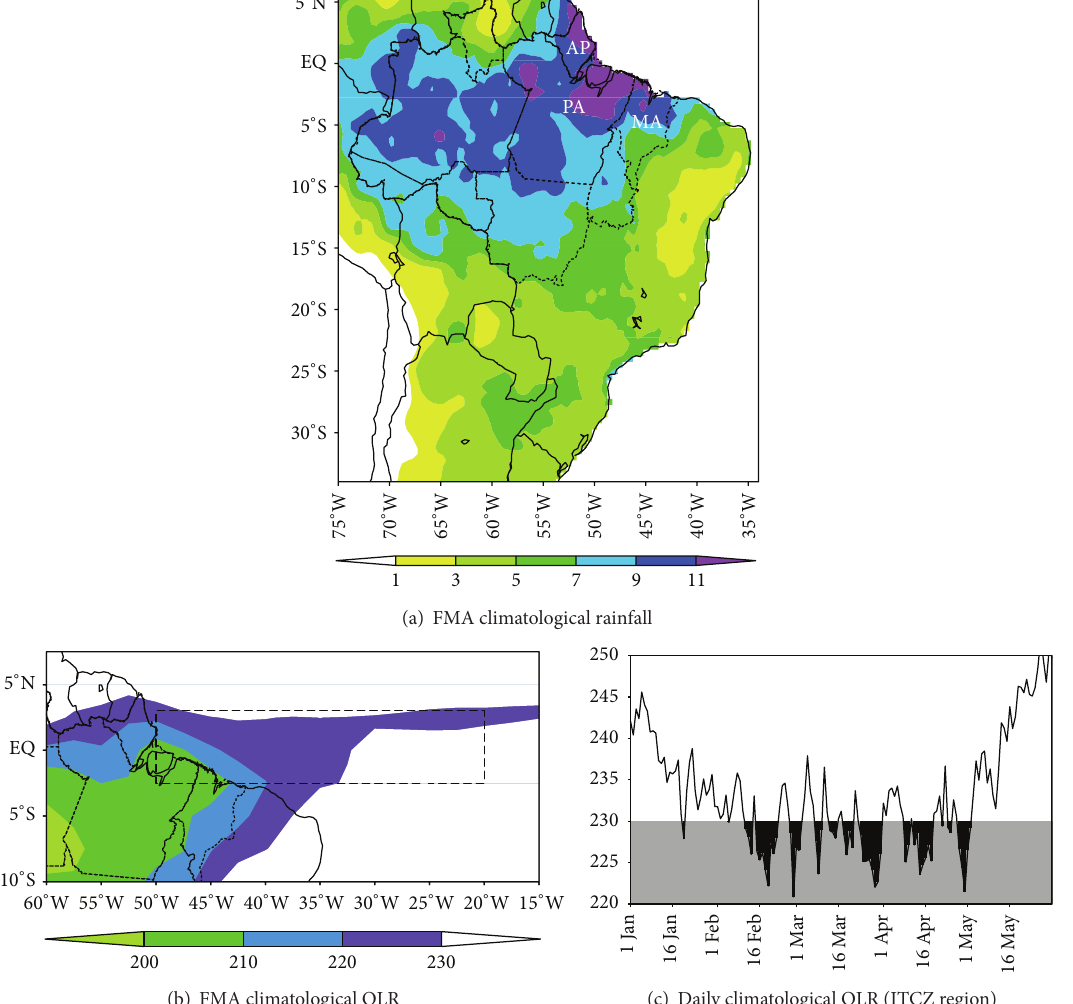
Figure 1: Climatology (1981/2010) for the FMA period of the (a) rainfall (mm/day) in South America and (b) OLR (W/m 2 ) in the Atlantic Ocean and eastern Amazon. (c) Time evolution from January to May of the daily climatological OLR (W/m 2 ) averaged in ITCZ region (2.5S/2.5N and 40W/10W; see location in dashed box). Black dashed lines in (a) show the limits of the states of the Brazilian Amazon, emphasizing AP (Amap´a), PA (Par´a), and MA (Maranh˜ao) in eastern